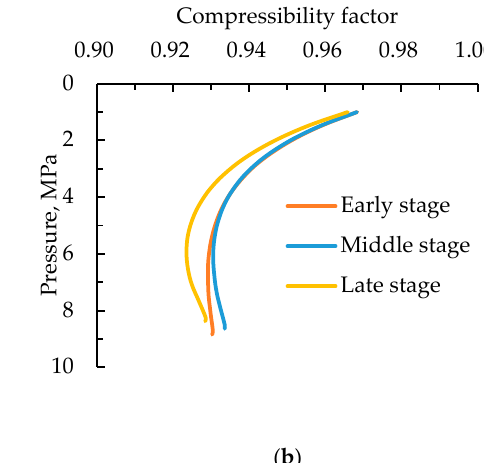
Figure 9. ( a ) The change in critical gas flow rate in different periods; ( b ) the change in compressibility factor in different periods.